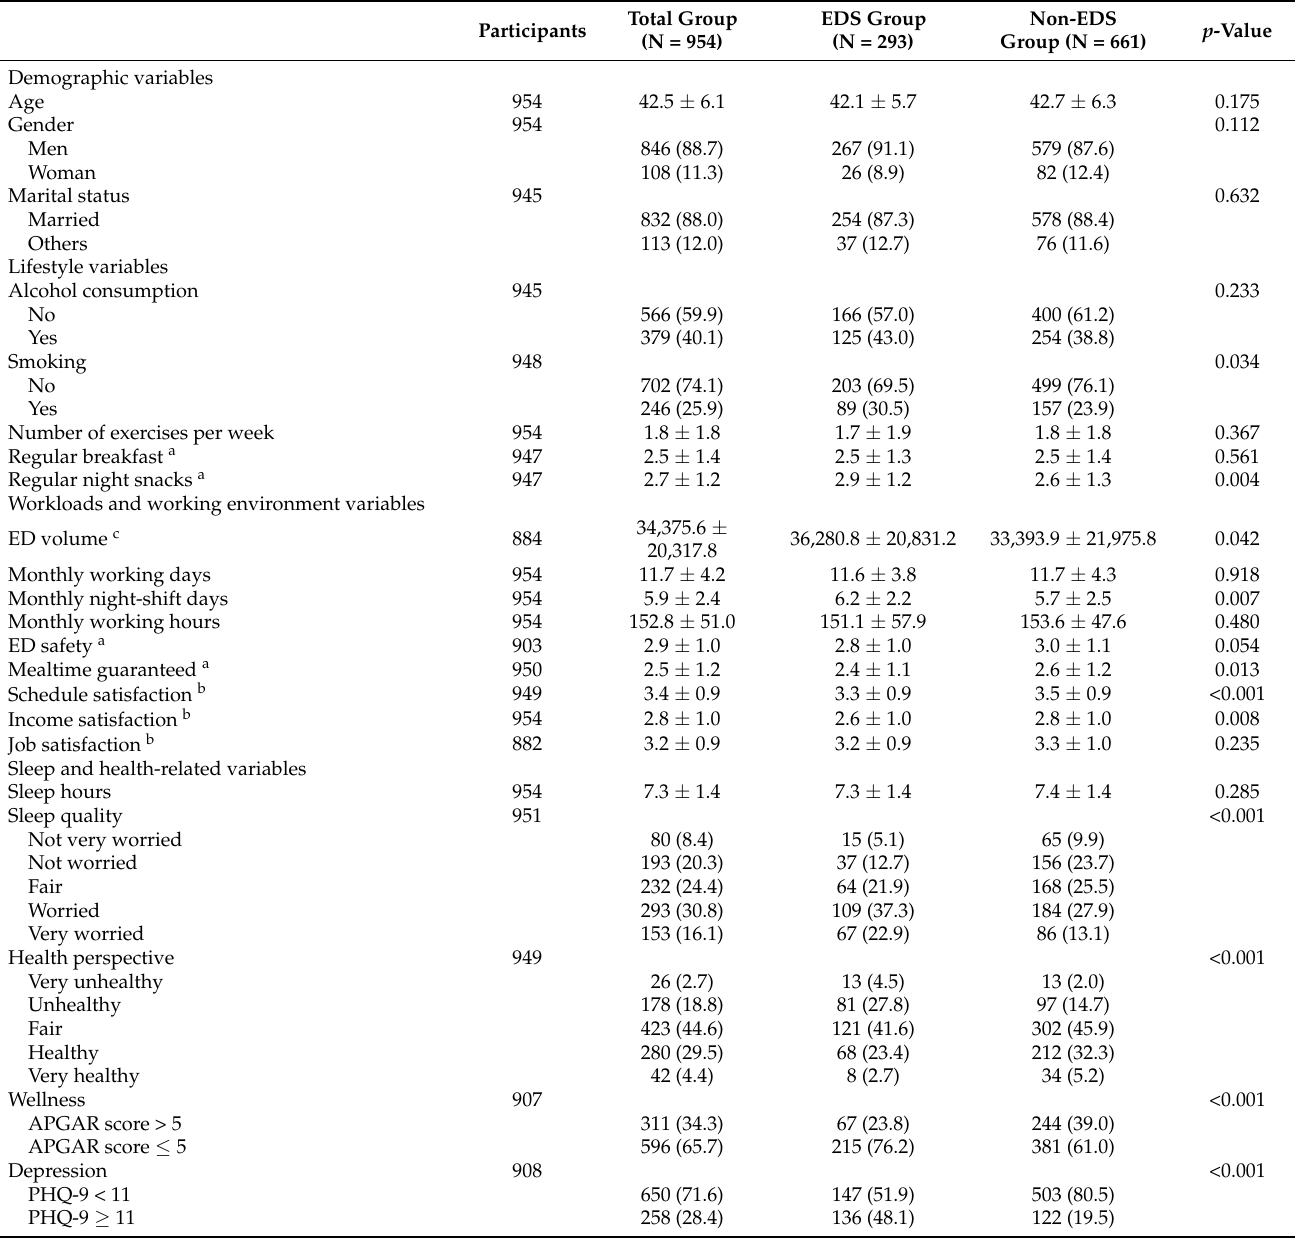
Table 1. Characteristics of